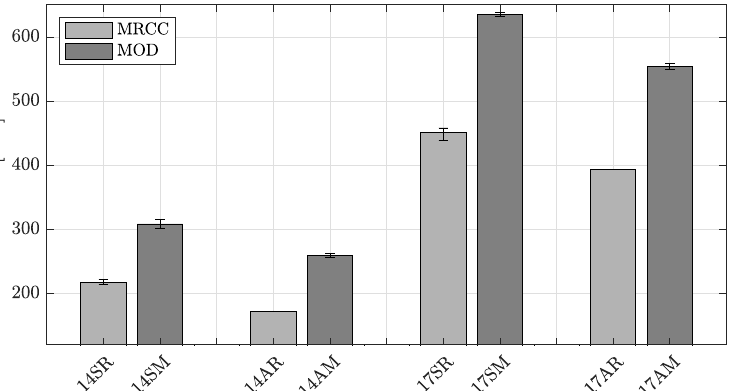
Figure 12. The modified cure cycle (MOD) clearly increases the radius of asymmetric specimens compared to the manufacturer-recommended cure cycle (MRCC), independent of tool material and specimen